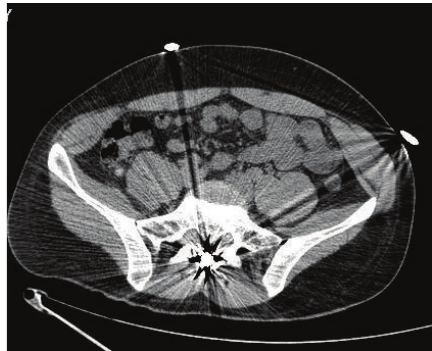
Figure 2: Axial CT scan demonstrates the intracanal position of the bullet and no damage to the posterior arc of S1-S2 level.